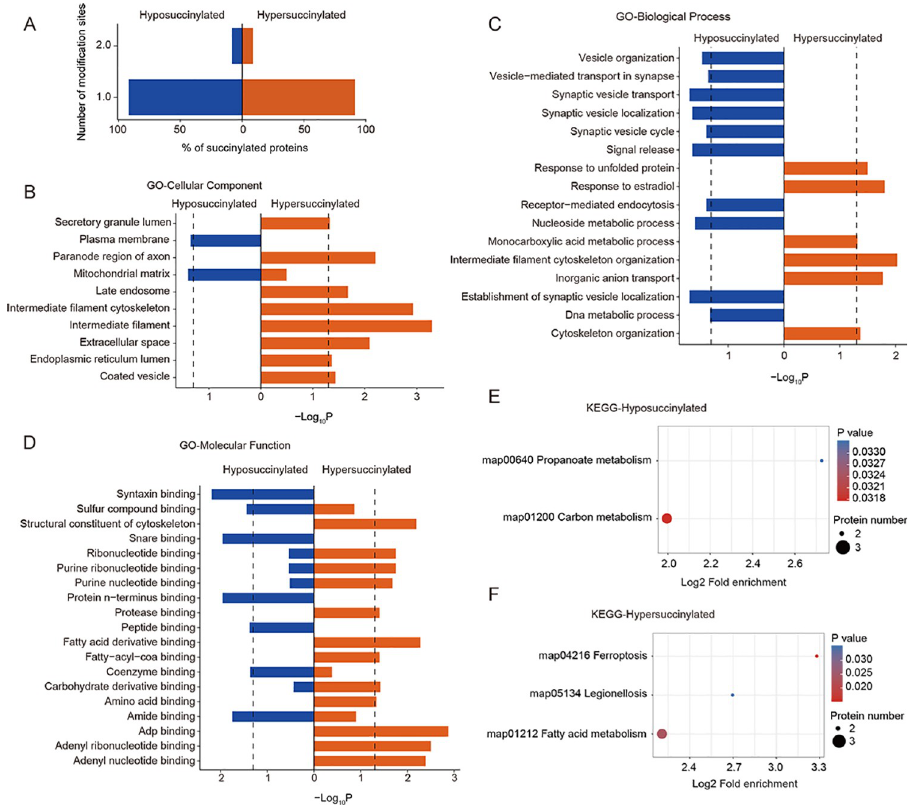
Fig 2. Analysis and annotation of differentially succinylated proteins in ICH brains. (A) Distribution of ICH- associated hyposuccinylated or hypersuccinylated proteins carrying the indicated number of succinylated sites per protein in vivo. The X-axis represents the percentage of hypo-and hyper-succinylated proteins (FC > 1.5 and P < 0.05) carrying 1 or 2 modification sites. The Y-axis represents the number of modification sites of hypo-and hyper- succinylated proteins (FC > 1.5 and P < 0.05). (B to D) GO analysis at the level of cellular component, biological process, and molecular function enriched in hyposuccinylated or hypersuccinylated proteins after ICH. (E and F) KEGG pathway analysis of hyposuccinylated or hypersuccinylated proteins after ICH. Significant enrichment is shown by Benjamini-Hochberg FDR-corrected P < 0.05 (outside the dashed line).